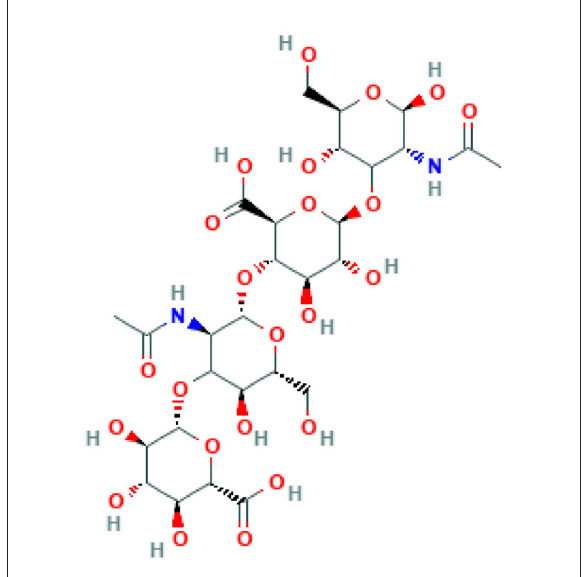
FIGURE2 Structure of hyaluronan. The structure is obtained from PubChem